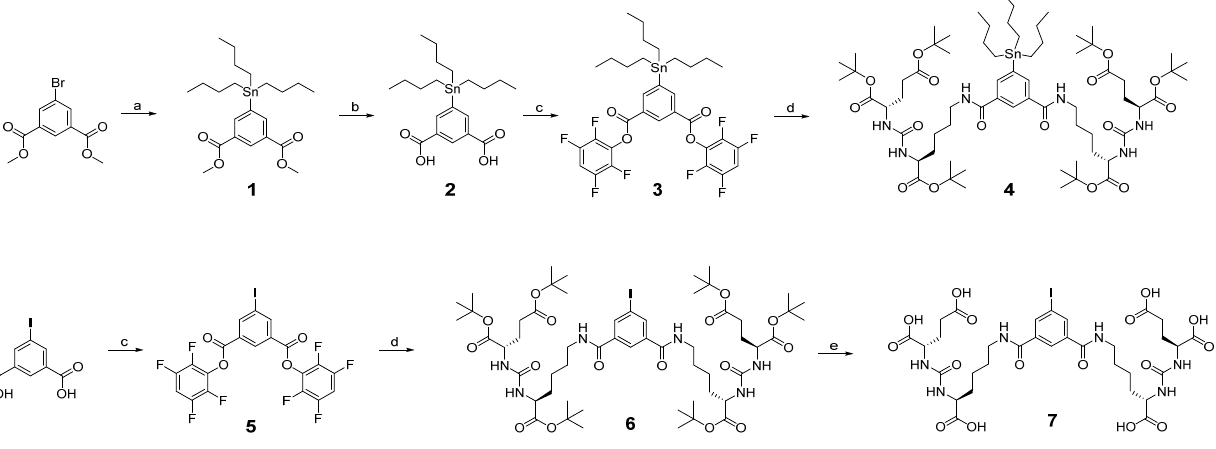
Figure 1. 125 I-PSMA-7 synthesis route map. Reagents and conditions: ( a ) 1, 4-Dioxane, bis (triphenylphoshine)palladium (II) chloride, reflux, overnight; ( b ) LiOH, MeOH/H 2 O, r.t., overnight; ( c ) 2,3,5,6-tetrafluorophenol, DCC (N, N’-dicyclohexylcarbodiimide), r.t., 8 h; ( d ) H-Lys-OtBu-ureido-Glu (OtBu) 2 , CH 2 Cl 2 , Et 3 N, r.t., 8 h; ( e ) CH 2 Cl 2 /CF 3 COOH = 1/1 ( v / v ), r.t., overnight.